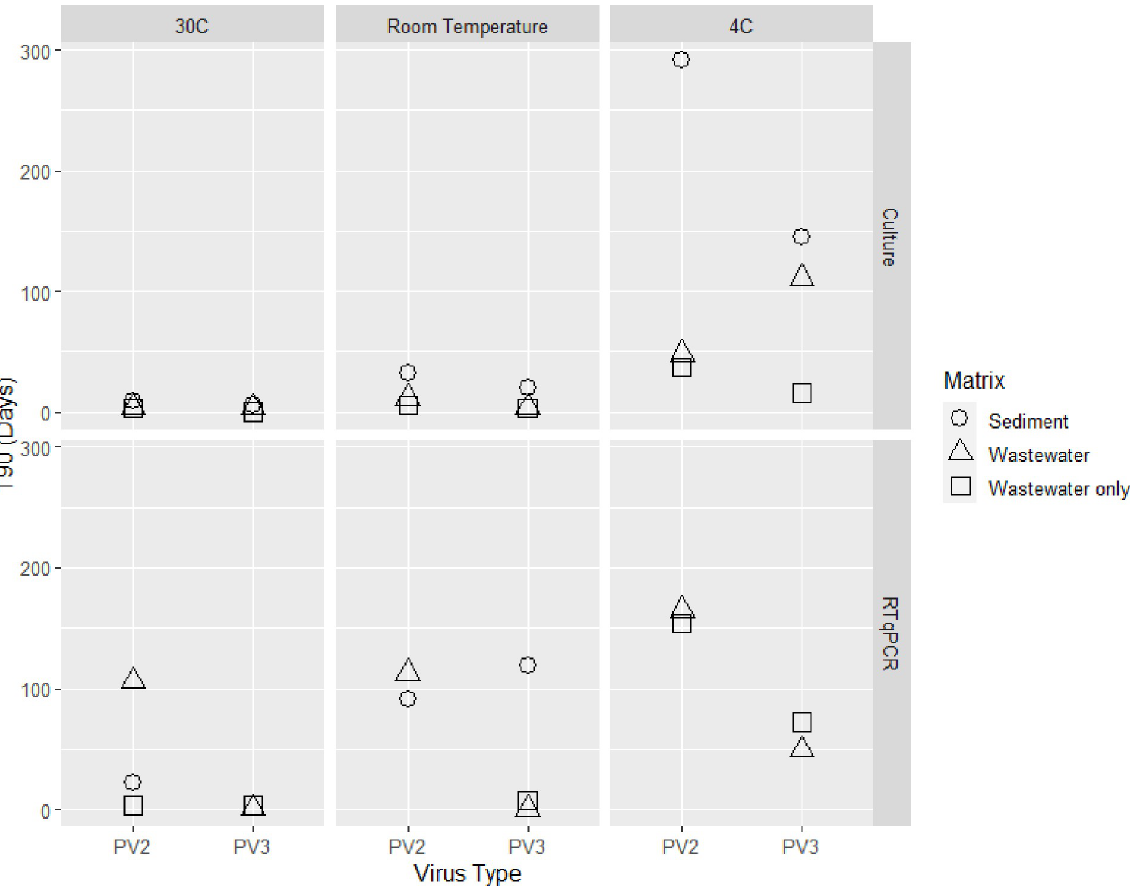
Fig 3. Visual presentation of the T90 values as influenced by the experiment matrix type, virus type, temperature, and method of detection. T90 is the time to 90% reduction. PV2 is poliovirus type 2. PV3 is poliovirus type 3.